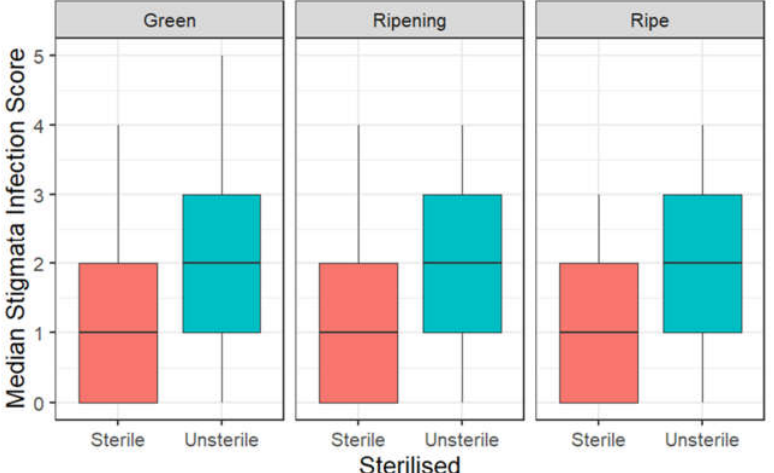
Figure 3. A boxplot of stigmata infection scores across the three developmental stages and between sterile vs. unsterile raspberry fruits; the black horizontal line is the median score. Table 2. The overall incidence (% fruit with Cladosporium present) of Cladosporium on stigmata across There were higher incidences of Cladosporium on stigmata across all the developmen- tal stages in the unsterilised treatments compared to the sterilised treatments (Table 2). four raspberry developmental stages and between sterilisation treatments. s.e.: standard error of the means. Sterilisation Treatment Green Ripening Ripe